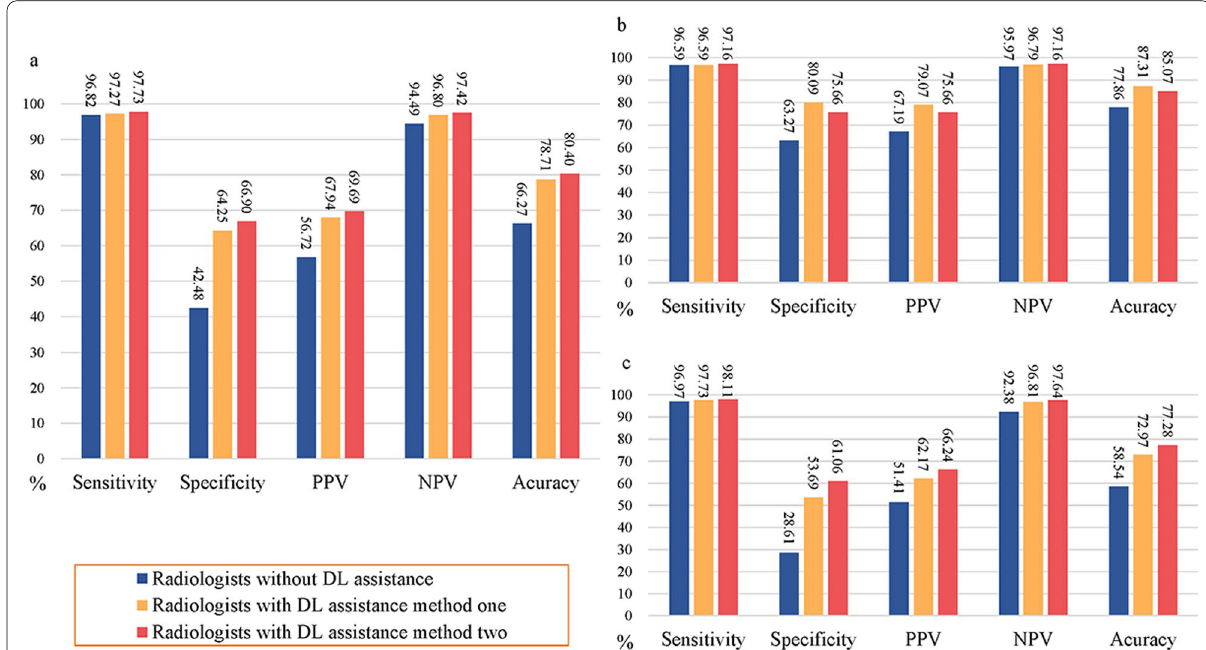
Fig. 4 Performance metrics for the radiologists with and without model assistance in the comparison set. a All the five radiologists; b experienced radiologists; c inexperienced radiologists. PPV, positive predictive value; NPV, negative predictive value; DL, deep